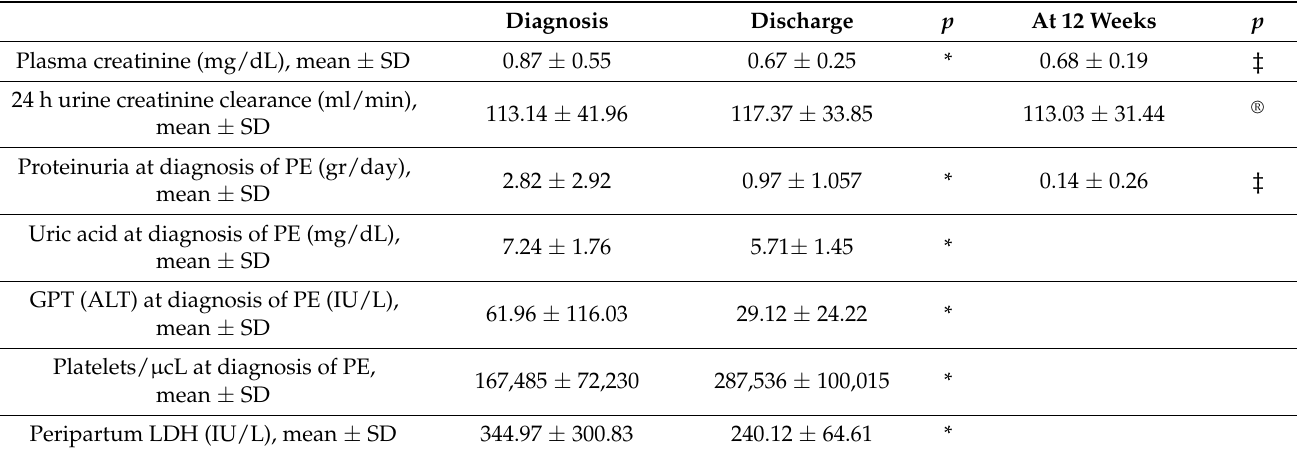
Table 3. Temporal evolution of laboratory parameters in cases of severe preeclampsia (PS) at the time of diagnosis, at hospital discharge and at 12 weeks after delivery. GPT = glutamic pyruvic transaminase; ALT = alanine aminotransferase; LDH = lactate dehydrogenase. * p < 0.001 between diagnosis and discharge, ‡ p < 0.001 between diagnosis and 12 weeks postpartum, ® was been significant and had only been performed in 69